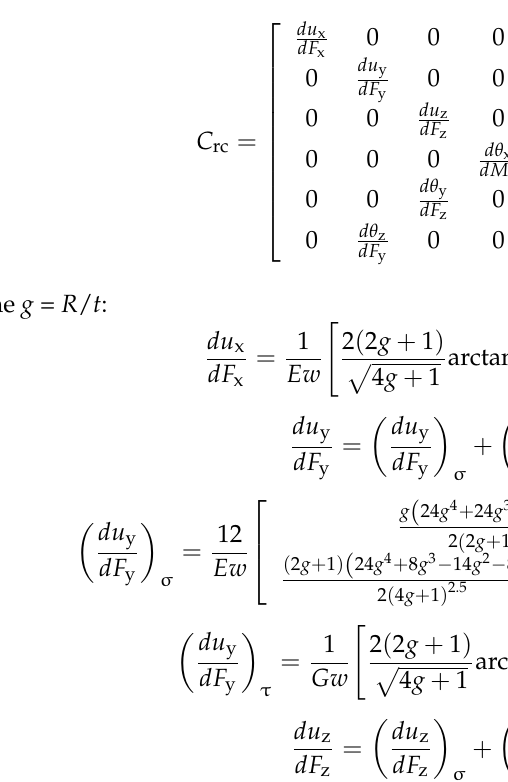
Figure 1. Structure of three kinds of flexure hinges: ( a ) right-angle; ( b ) right-circle; ( c ) “Z-shaped”. For the basic right-circle flexure hinge, the compliance matrix C rc is shown in the following [29]: